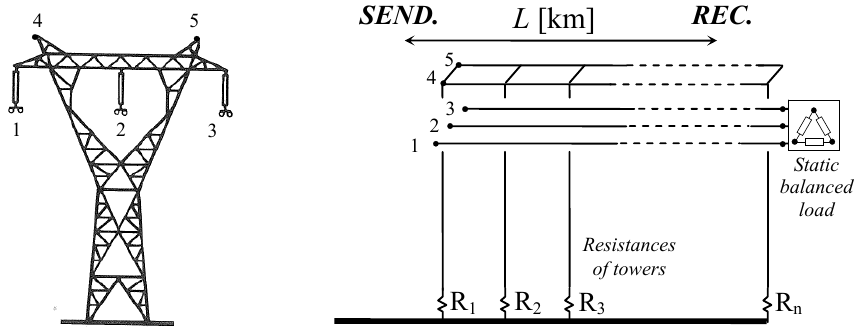
Figure 1. Multiconductor representation of OHL supplying a static balanced load; SEND—sending-end;